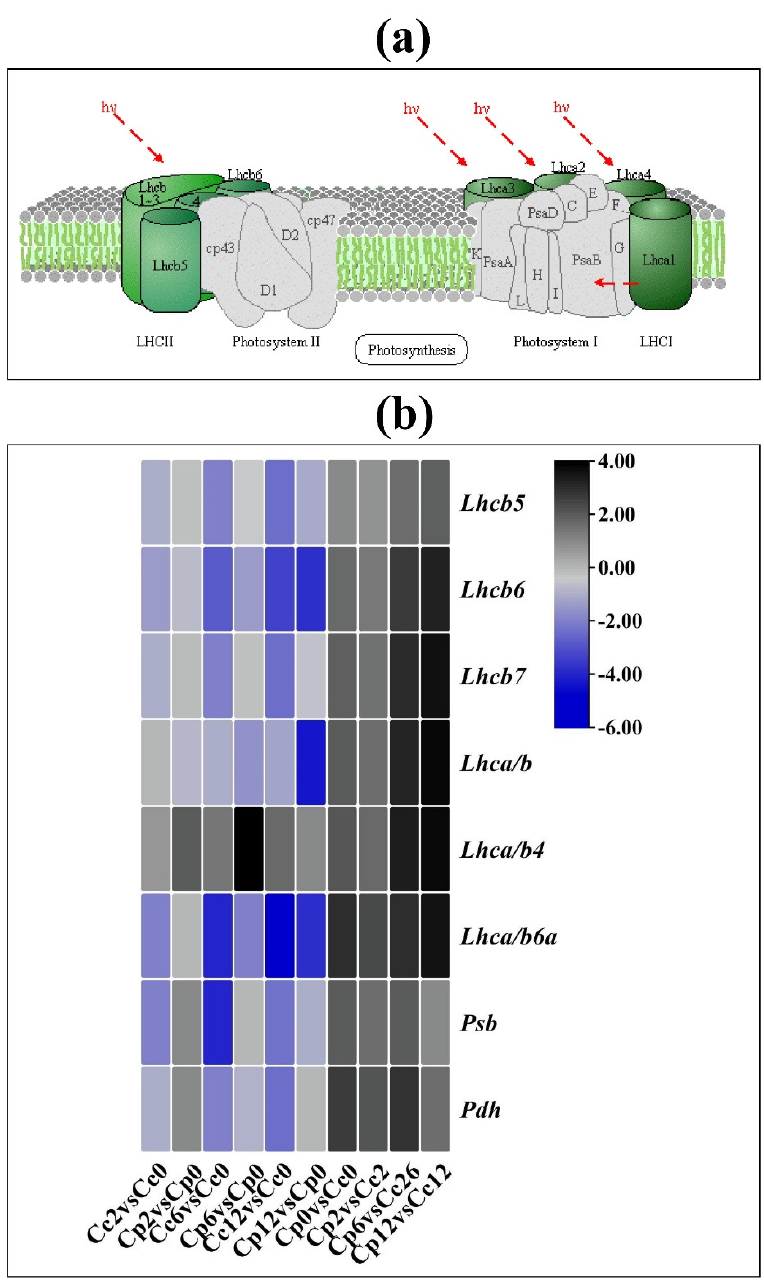
Figure 6. ( a ) Schematic representation of light harvesting pathway in plants (KEGG: Kyoto ency- clopedia of genes and genomes). ( b ) Differentially expressed photosynthetic pathway genes in the cold-treated C. pubescens and C. chinense pepper seedlings at different time points.